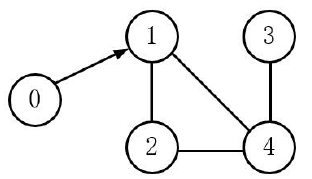
Figure 1. Communication network ¯ G